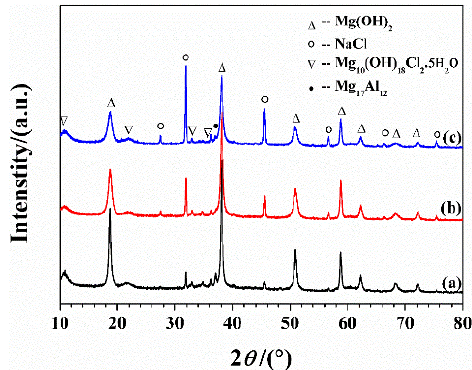
Figure 11. XRD patterns for the discharge products of AZI1.0 alloy, 10 mA·cm −2 , 20 h ( a ), 100 mA·cm −2 , 2 h ( b ) and 200 mA·cm −2 , 1 h ( c ).